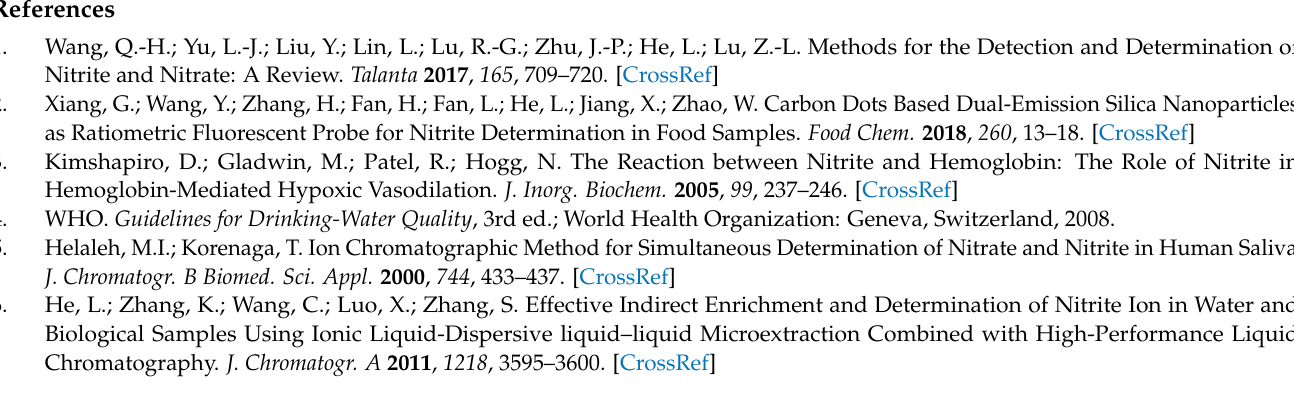
Figure S2: EDS (A) and elemental mapping images (B–E) of hollow MnFeO. Figure S3: TEM image of hollow MnFeO. Figure S4: N 2 adsorption/desorption curves (A) of hollow MnFeO and its pore size distribution (B). Figure S5: Comparison of FTIR spectra of different materials. Figure S6: Full XPS of hollow MnFeO. Figure S7: Effect of buffer pH on hollow MnFeO catalyzing the TMB chromogenic reaction. Figure S8: The absorbance (652 nm) of the hollow MnFeO + TMB system increases along with the amount of hollow MnFeO used. Figure S9: Absorbance (652 nm) change of the hollow MnFeO+TMB system over reaction time. Figure S10: Neither Mn-Fe PBA nor hollow Mn-Fe PBA shows oxidase-like activity to catalyze the TMB chromogenic reaction. Figure S11: Oxidase-like activity comparison of MnFeO and hollow MnFeO catalyzing the TMB chromogenic reaction. Figure S12: No chromogenic reaction occurs between hollow MnFeO and nitrite. Figure S13: Ascorbic acid (AA) can re-reduce blue TMBox and yellow overoxidized TMBox to colorless TMB, while it cannot re-reduce diazotized TMBox to colorless TMB (the concentrations of nitrite and AA are 100 µ M). Figure S14: Nitrite can trigger the oxidation and diazotization of TMB (the concentration of nitrite is 100 µ M). Figure S15: Response comparison of various species toward the hollow MnFeO+TMB system (the concentrations of various species are 50 µ M). Figure S16: Change of the ratiometric colorimetric signal over the reaction time of TMBox and nitrite. Figure S17: (A) displays UV-vis spectra of the TMB+NO 2 − system with nitrite at various levels (the concentration of nitrite increases from 0 µ M to 233.3 µ M), and (B) shows the linear relationship between absorbance (439 nm) and nitrite concentration. Figure S18: The linear relationship between absorbance (540 nm) and nitrite concentration obtained by the commercial kit, Table S1: Comparison of kinetic parameters of oxidase- mimicking hollow MnFeO catalyzing the TMB oxidation reaction with that of other oxidase mimics. Table S2: Comparison of our ratiometric colorimetric assay with previously reported methods using TMB as a reagent for nitrite detection. Table S3: Comparison of our ratiometric colorimetric assay with previously reported nitrite detection